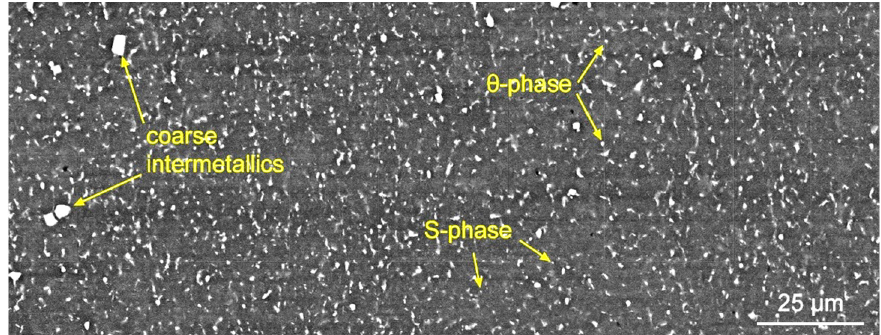
Figure 6. SEM image of stir zone in a longitudinal